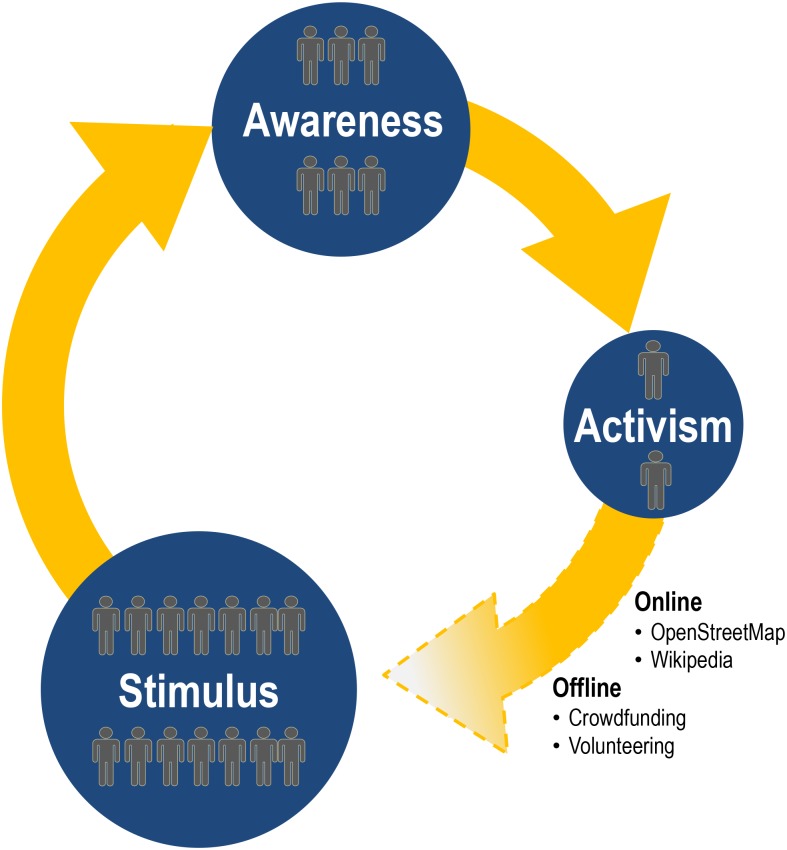
Stimulus-awareness-activism (SA2) framework.